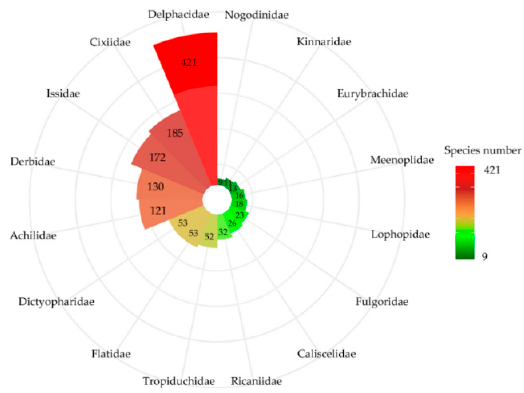
Figure 1. Species number in each planthopper family.